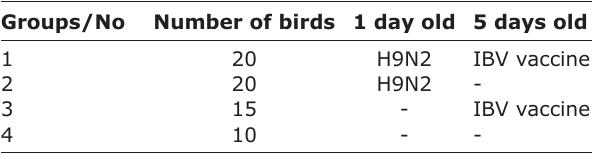
Table-1: The different treatment used in experiment 1. Groups/No